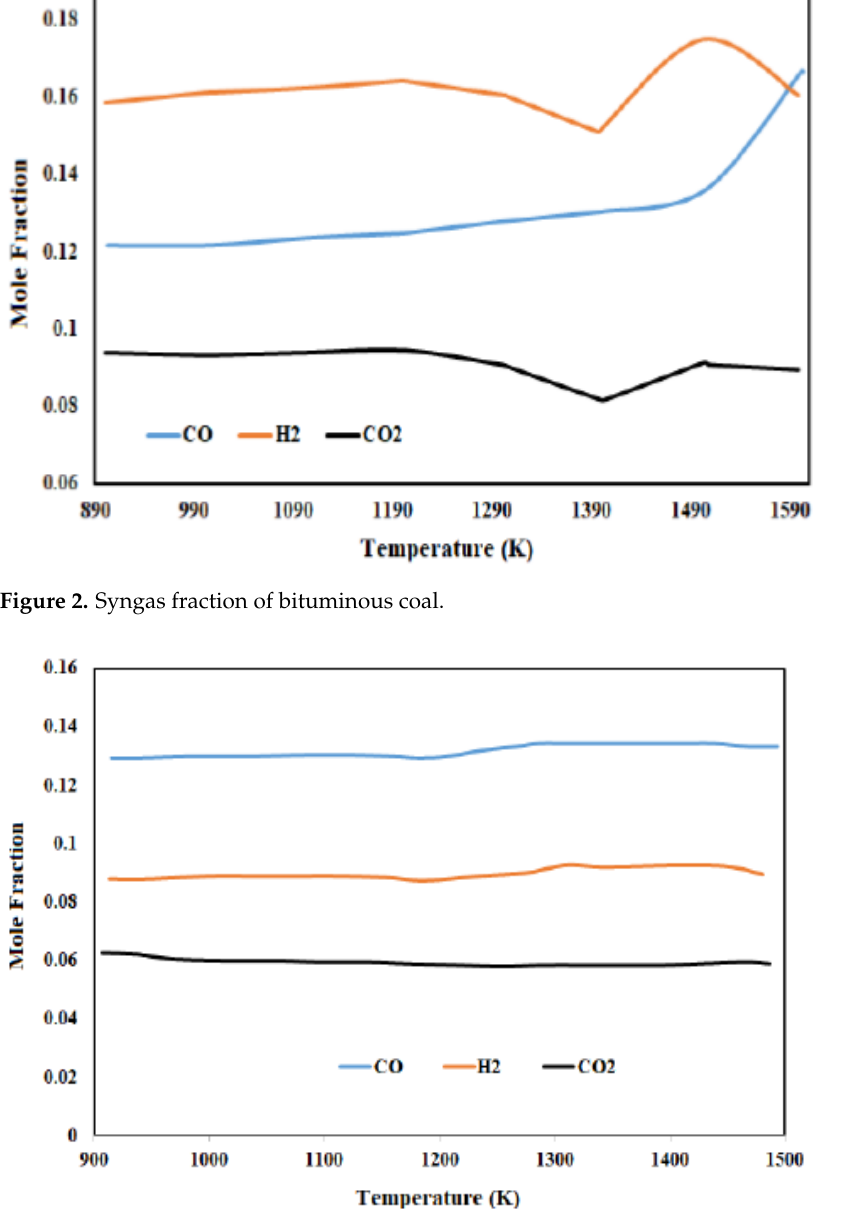
Figure 3. Syngas fraction of Thar lignite